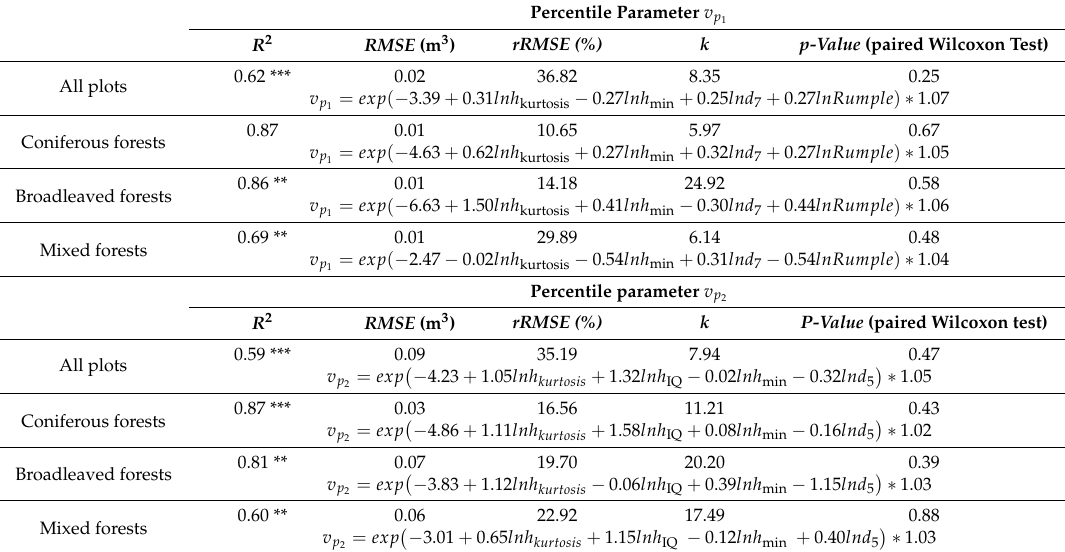
Table 4. Statistics for percentile-based parameter recover method (PPRM) models for percentile parameter v p and v p (i.e., 24th and 93rd percentiles). 2 1